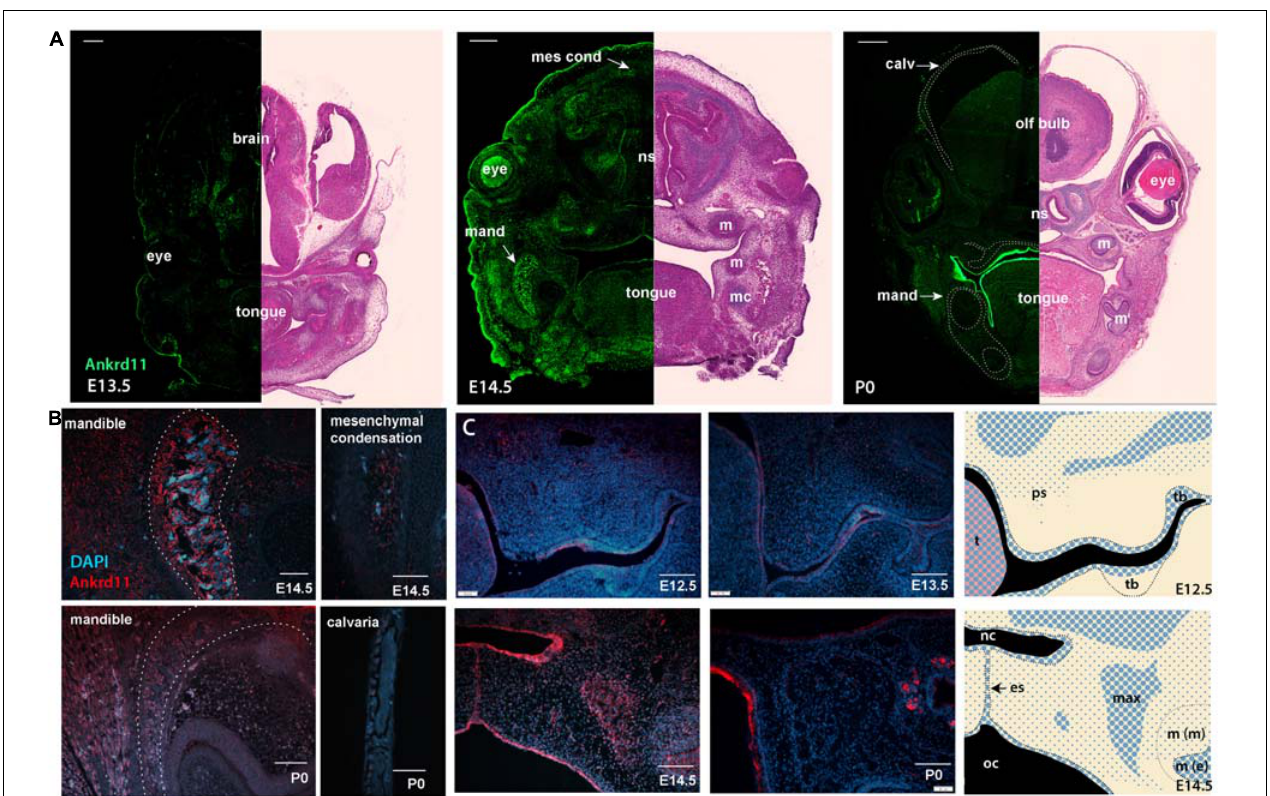
FIGURE 4 | Ankrd11 is expressed in embryonic craniofacial tissues. Expression pattern of Ankrd11 on immunofluorescent staining of Ankrd11 ctrl coronal paraffin sections. (A) Split view of coronal sections of C57/BL6 mice immunostained for Ankrd11 (left, green) or processed for H&E for morphological orientation (purple, right) at ages E13.5, E14.5 and P0. ns, nasal septum; mand, mandible; m, molar; mc, Meckel’s cartilage; olf bulb, olfactory bulb of brain; calv, calvaria. White dotted lines on P0 immunofluorescent panel outline bony structures of the craniofacial complex including calvaria, maxillary/palatine bones, and mandibular bone shown in (B) . Scale bars represent 200 µ m (left) and 500 µ m (right). (B,C) High magnification representative images from coronal sections immunostained for Ankrd11 (red), with DAPI nuclear counterstain in blue from mandible and calvaria (B) as well as palatal shelves (C) . White dotted lines in (B) (mandible panels) indicate boundaries of mandibular bone indicated in (A) . Cranial/calvarial images are taken from comparable anatomic locations indicated in (A) . Images in (B,C) are presented from E14.5 and P0. Images in (C) are presented from E12.5, E13.5, E14.5, and P0. Graphic representation of Ankrd11 expression at E12.5 and E14.5 in right panels created in Adobe Illustrator. Blue represents Ankrd11 expression, with larger dots indicating relatively brighter regions. n = 3 from 3 litters. Scale bars in (B) represent 50 µ m, except for E14.5 calvaria (200 µ m). Scale bars in (C) represent 100 µ m. ps, palatal shelf; t, tongue; tb, tooth bud; nc, nasal cavity; oc, oral cavity; es, epithelial seam; max, developing maxillary bone; m(m), molar (mesenchymal portion); m (e), molar (epithelial